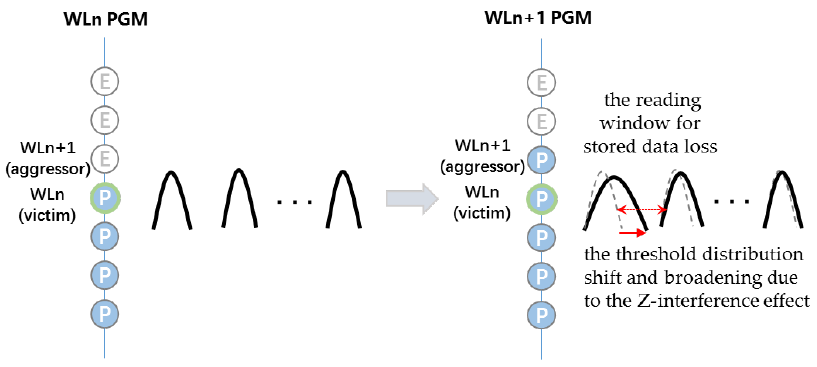
Figure 1. Schematic diagram of z-interference’s impact on the 3D NAND device’s reliability.